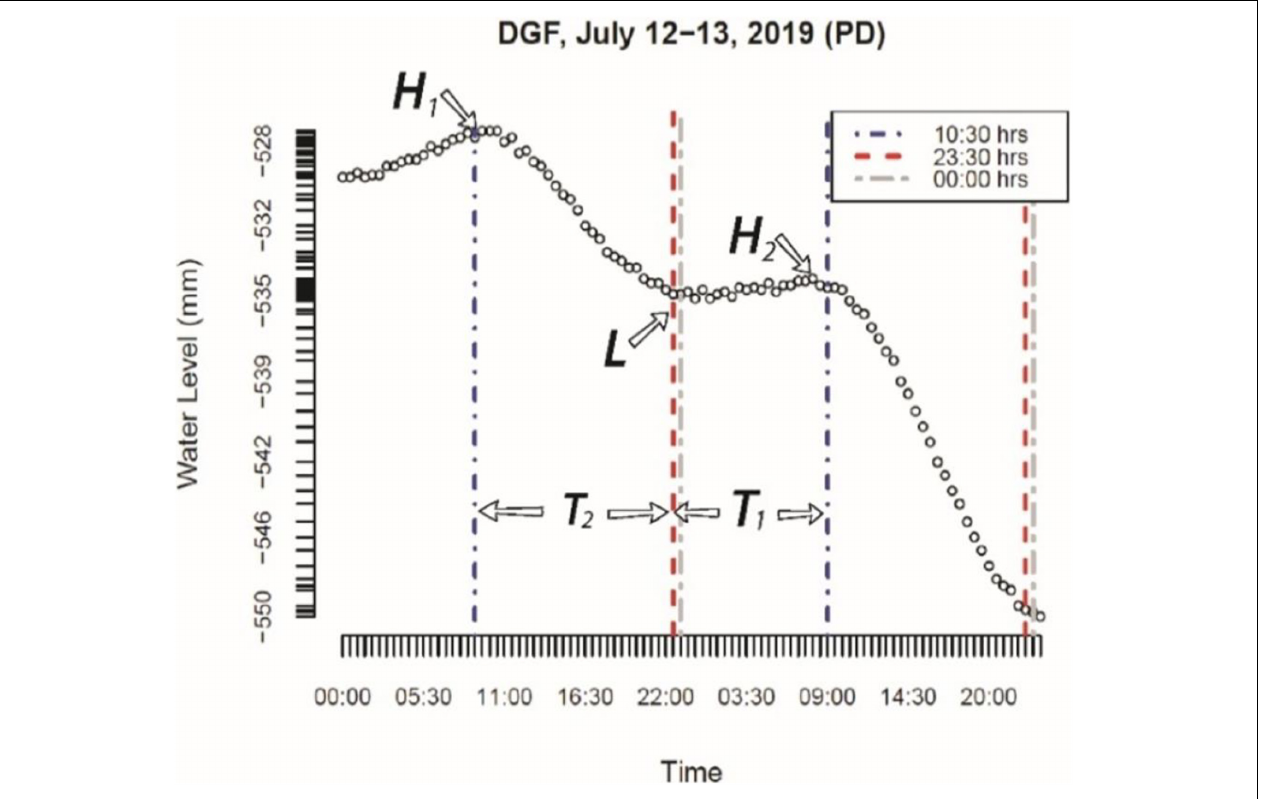
FIGURE 2 | An example of diurnal water table fluctuation (DGF) on a rain-free day at PD. Negative values indicate